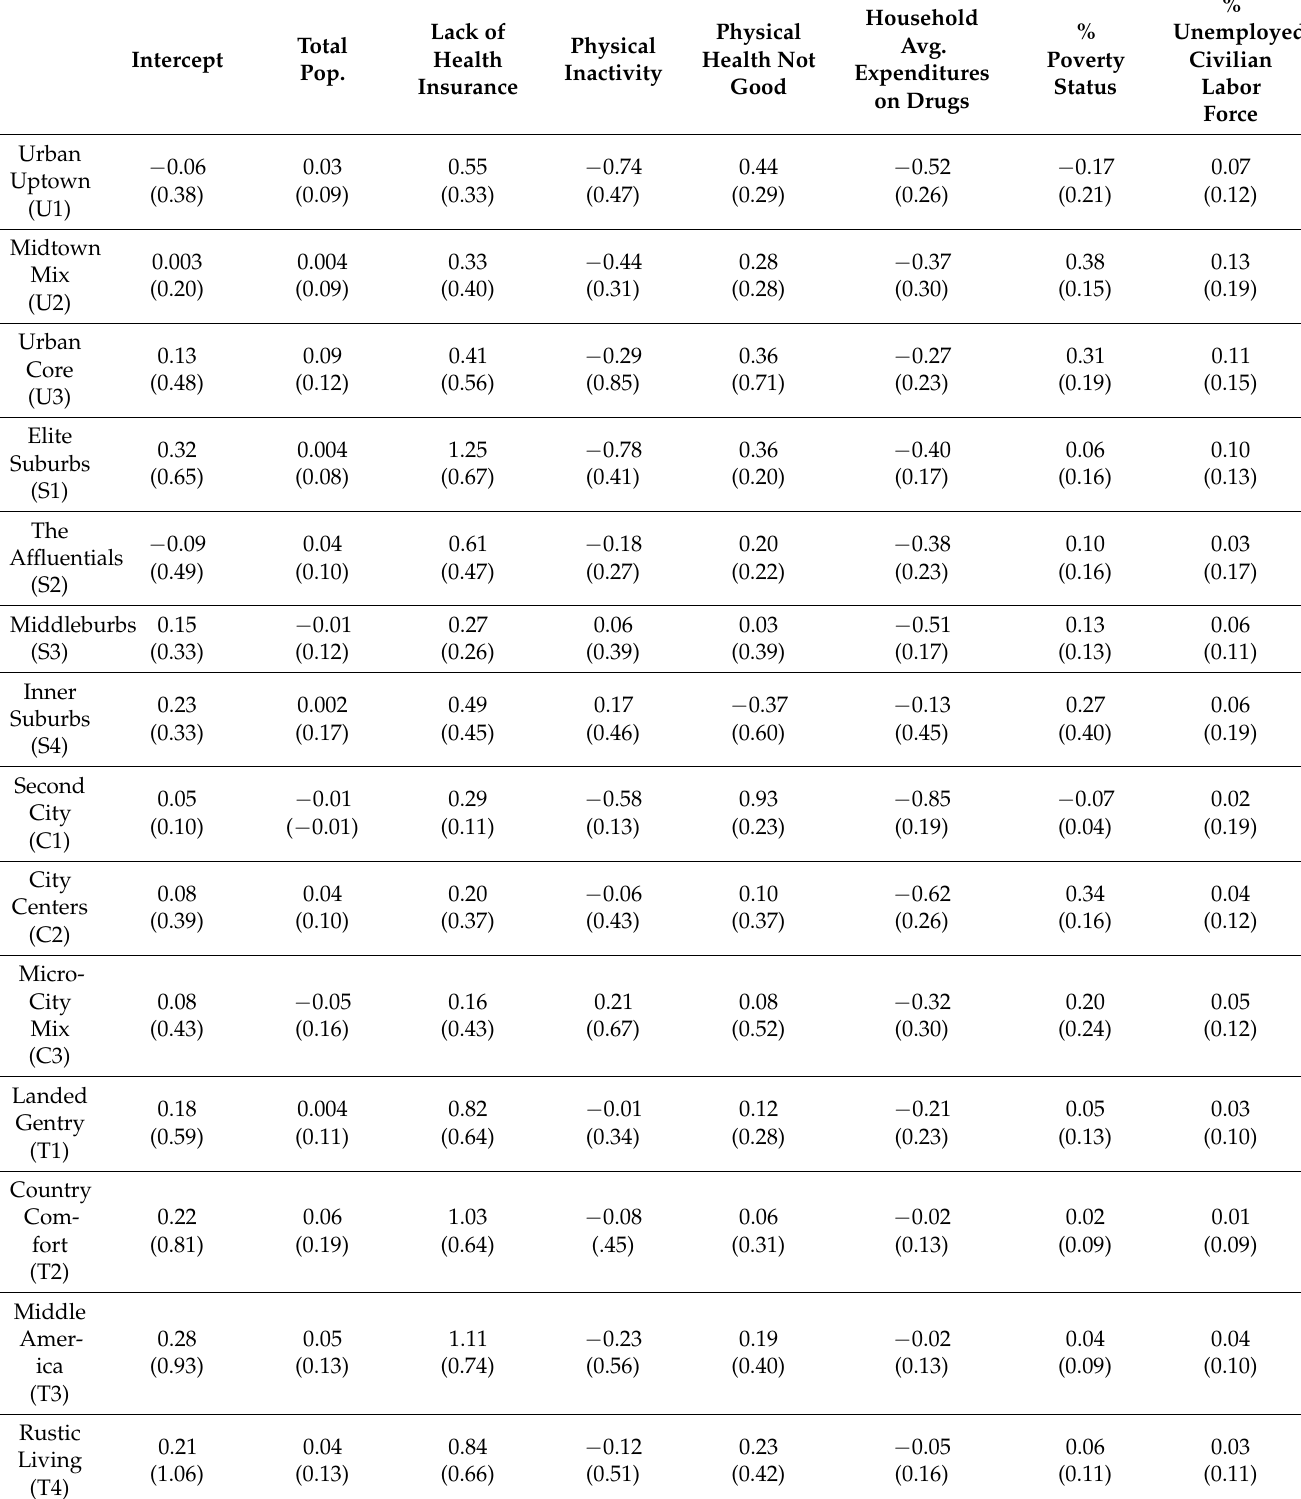
Table 4. Mean and standard deviations of coefficient estimates across social